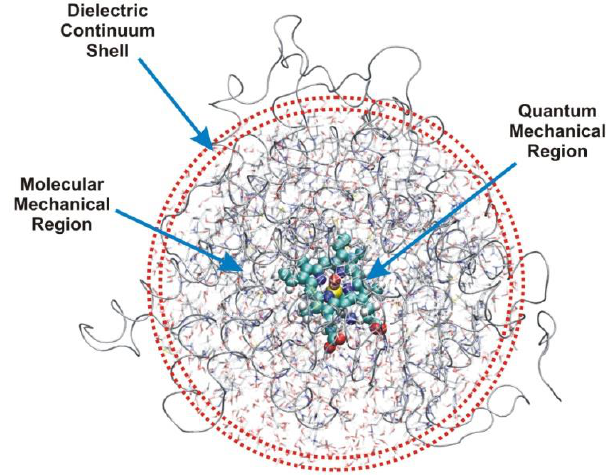
Figure 1. Hierarchical composition of a full enzyme system. Active site or quantum mechanical region ( A ); protein core or molecular mechanical region ( P ); bulk or dielectric continuum shell ( B ) (figure drawn on the basis of the crystal structure of human aromatase,